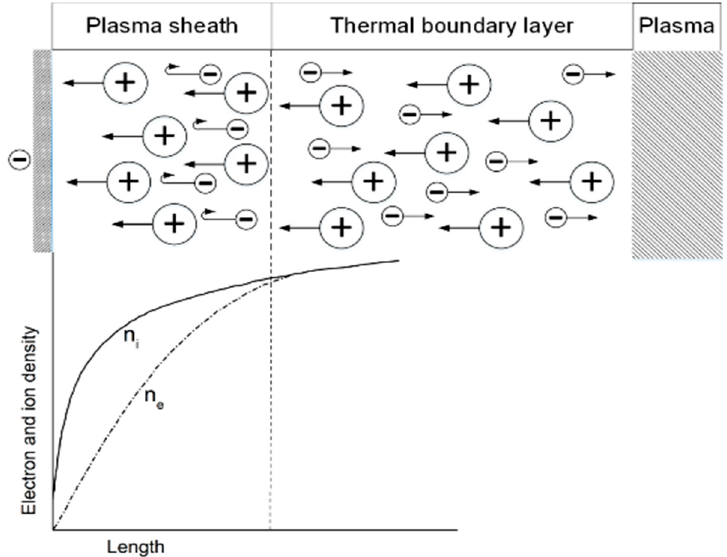
Figure 5. Motion of the activated particles near a negative reaction surface [23,38] .